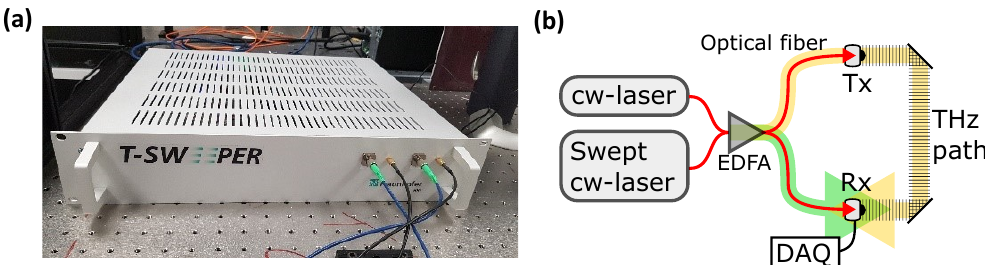
Figure 1. T-Sweeper. ( a ) Photograph of the instrument. ( b ) Schematic drawing of instrument operation, components, and the optical and THz beam paths. Extracted from [22]. Tx—transmitter; Rx—receiver; DAQ—data